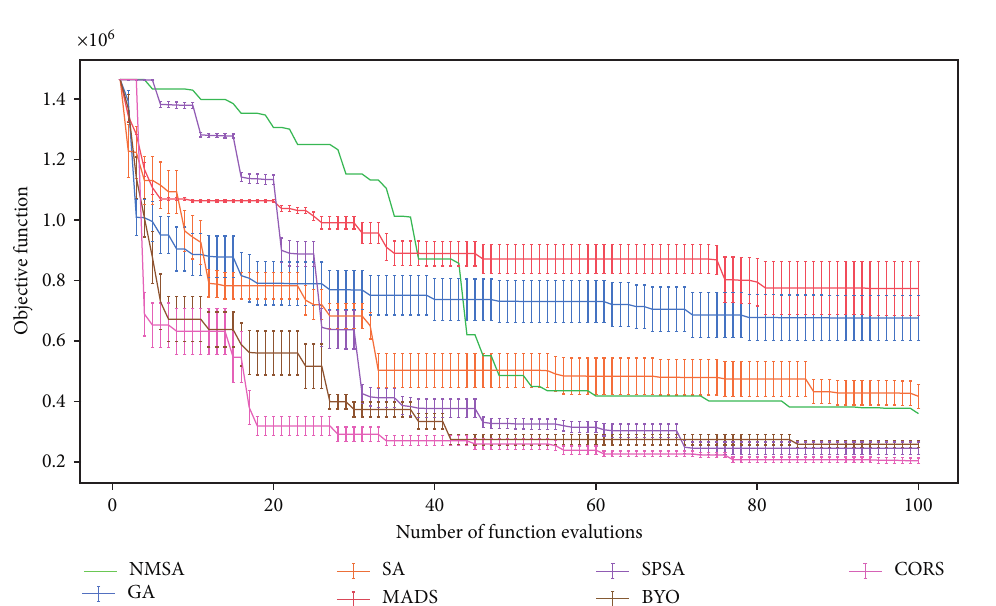
Figure 3: Convergence results of reference scenario. The error bar indicates 1/4 × standard deviation. NMSA has no error bar because it is a deterministic algorithm.